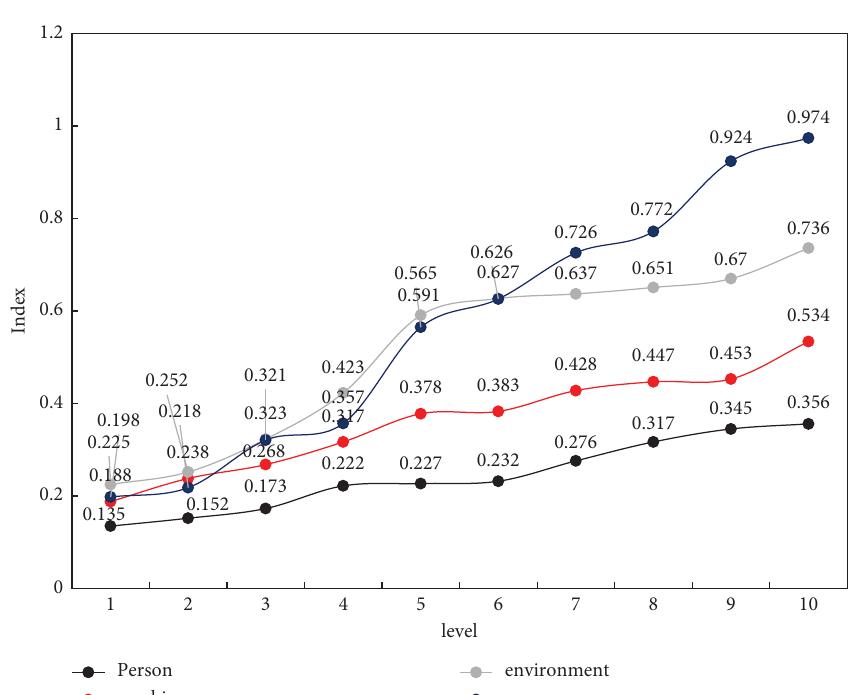
Figure 10: Comprehensive level of civil engineering construction safety